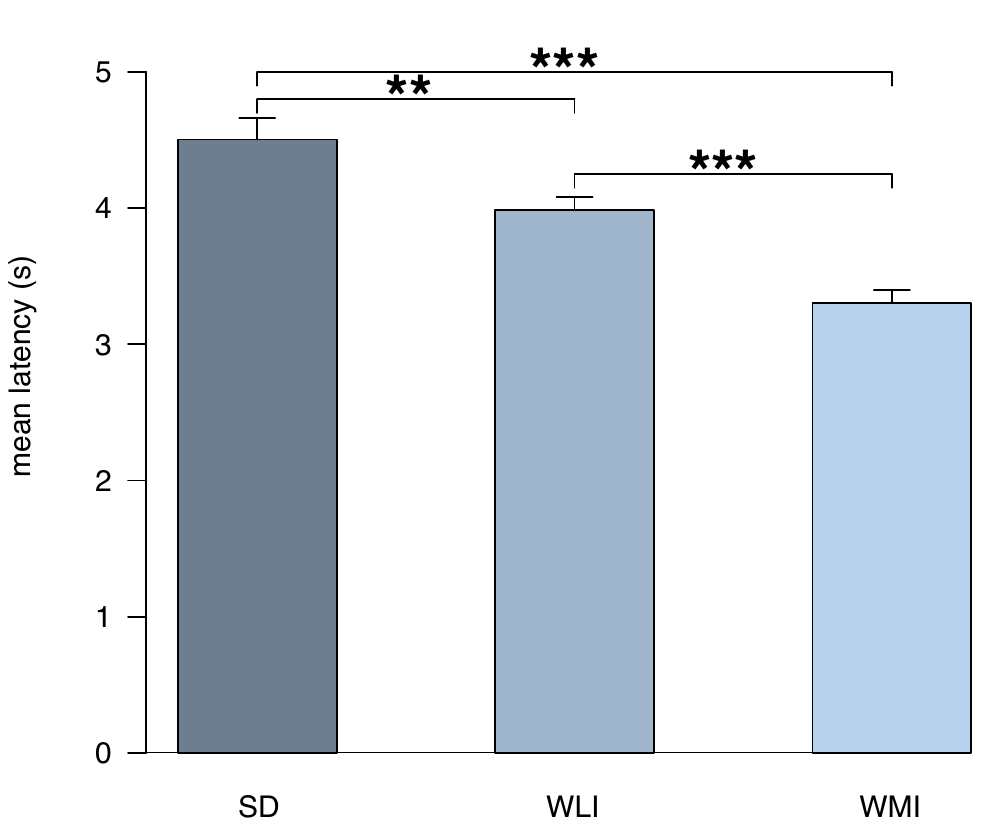
Fig 4. TailTimer detects strain differences in baseline pain thresholds. The tail immersion assay was performed to determine baseline tail withdrawal latencies for males of the outbred SD strain ( n = 8) and of the WLI ( n = 7) and WMI ( n = 6) inbred strains. Baseline measurements were collected for each rat on two separate, consecutive days. Mean latencies reflect the average of the (four–eight) tests per individual rat, averaged across strain. Data are expressed as mean ± SEM; �� p = 0.006, ��� p <